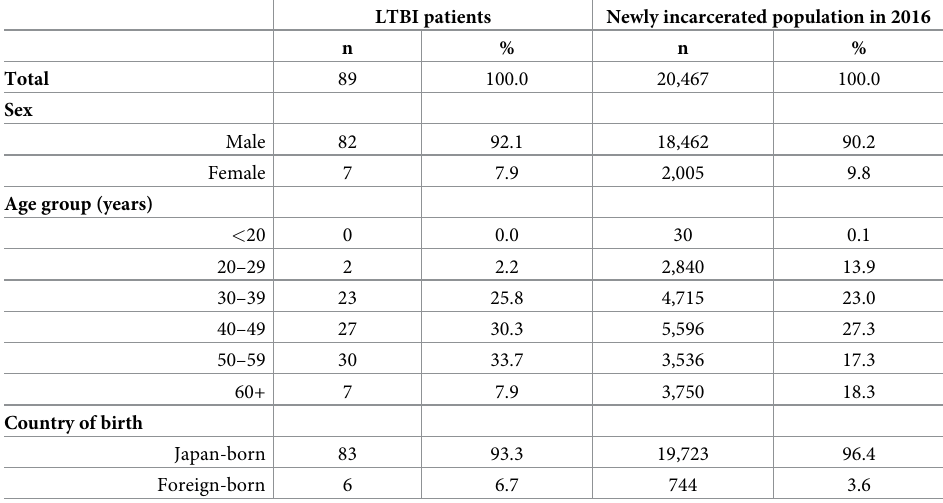
Table 2. Characteristics of newly notified LTBI patients from correctional facilities,